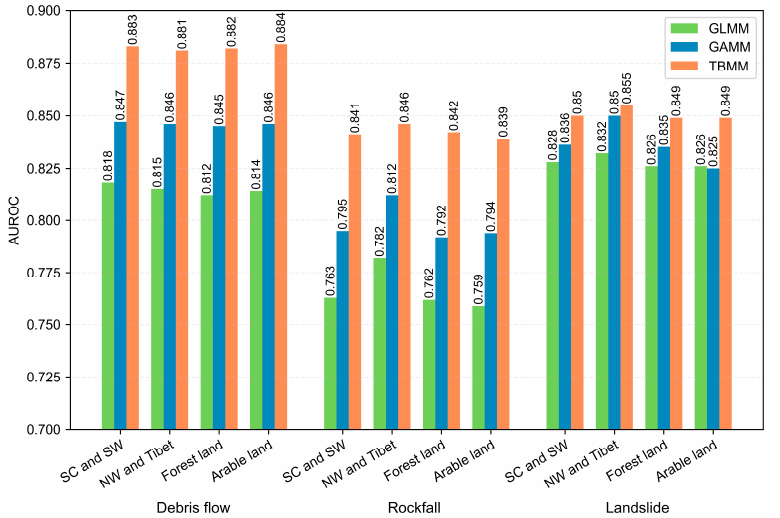
Figure 7. Comparison of model predictions (AUROC) for different types of mass movements based on highly incomplete data.